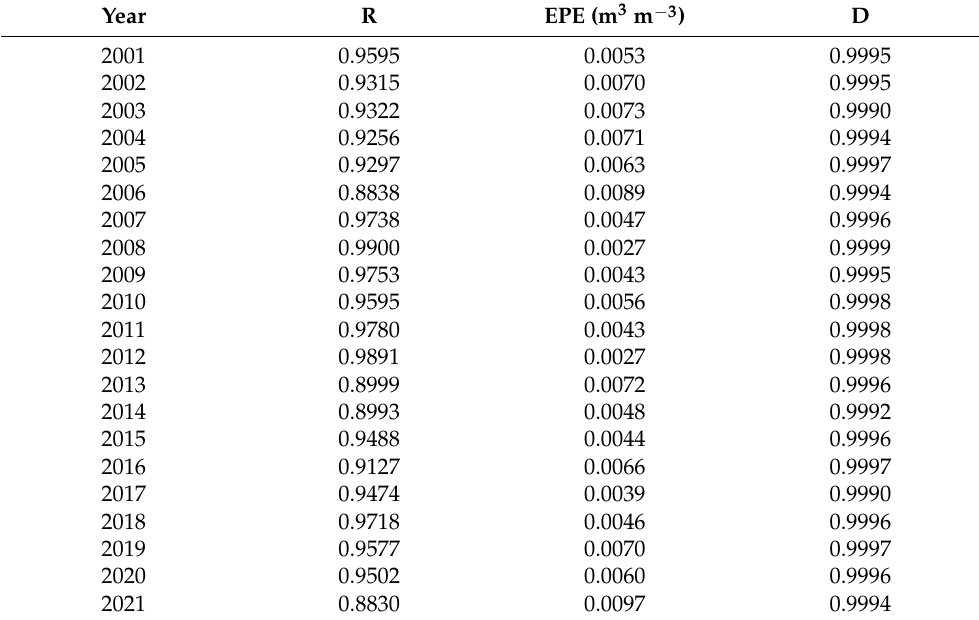
Table 2. Statistical variables of the correlation of observed and simulated VSM data.